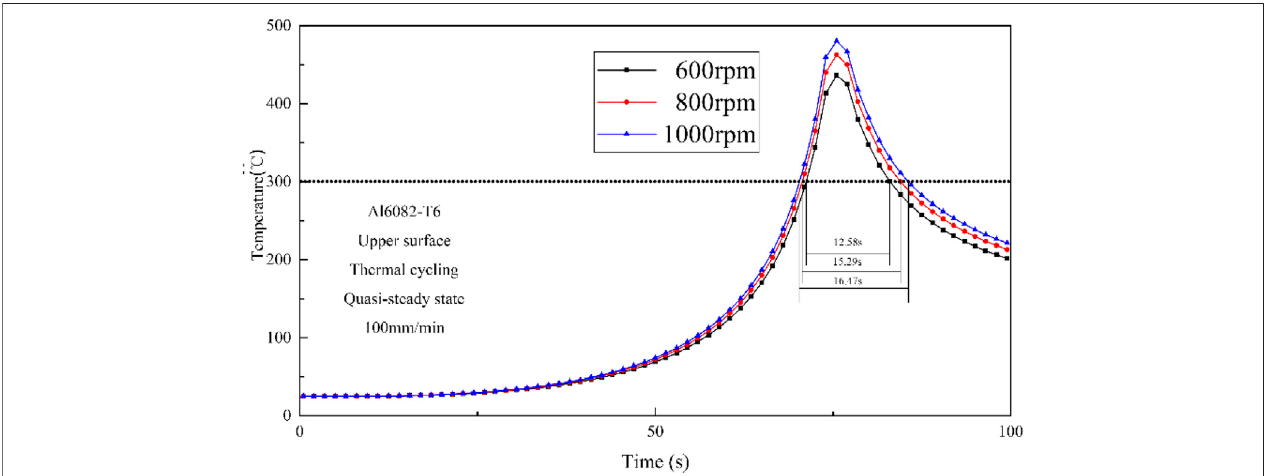
FIGURE 18 | Thermal cycle curves of feature points under different rotation